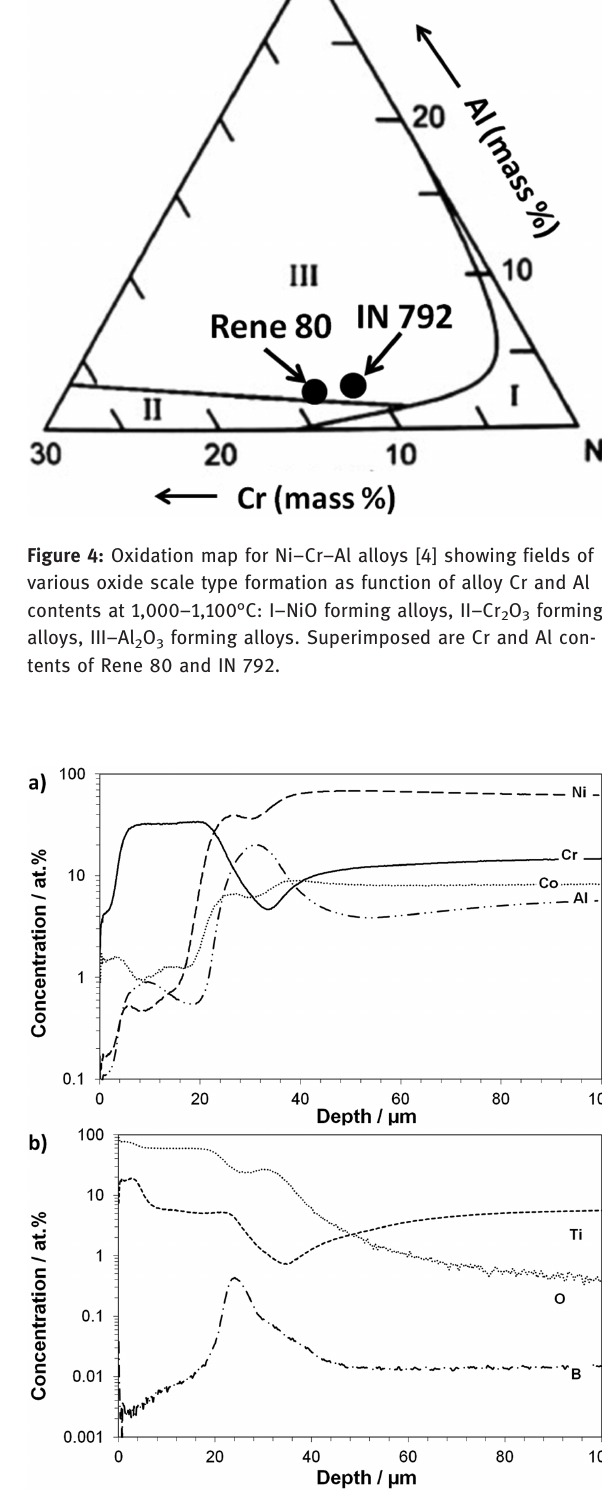
Figure 5: GD-OES depth profiles of Rene 80 after oxidation at 1,050°C in Ar – 20% O 2 for 50 h showing the depth profiles of (a) major and (b) minor alloying